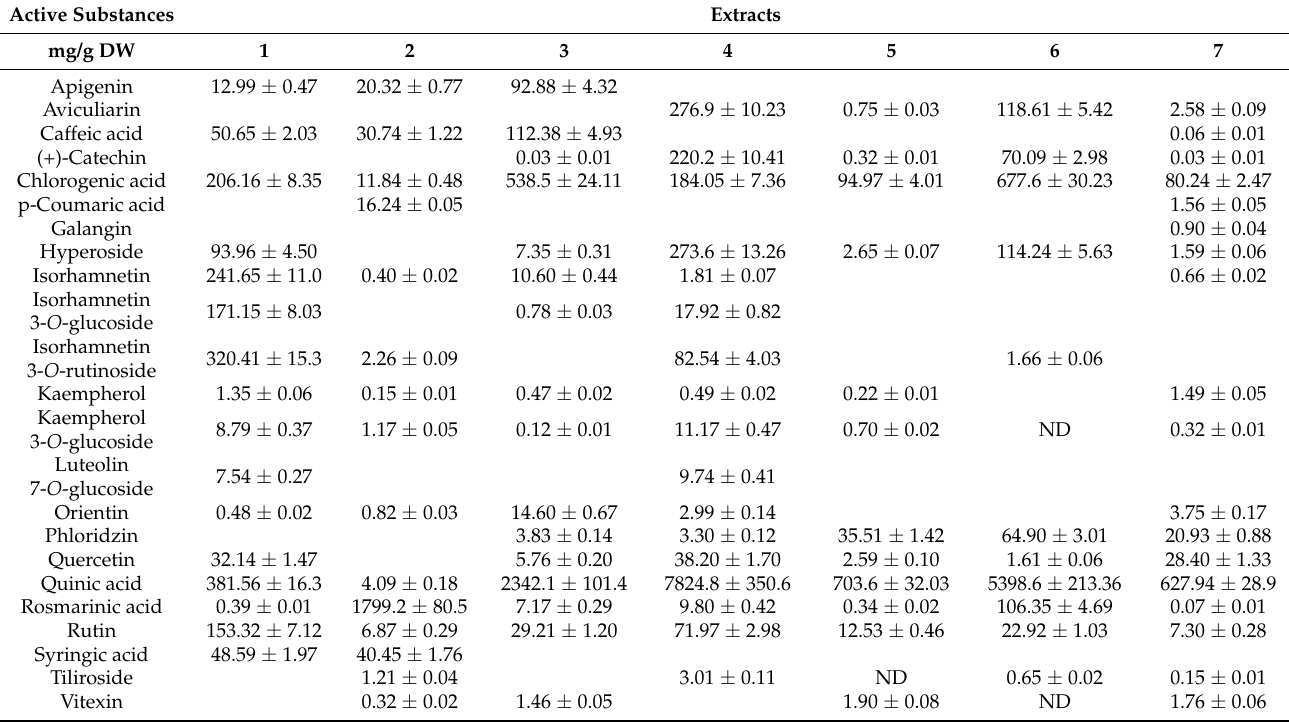
Table 2. Chemical composition of extracts. Grey colour—tested substance was not detected, blue colour—very high amount of tested substance was